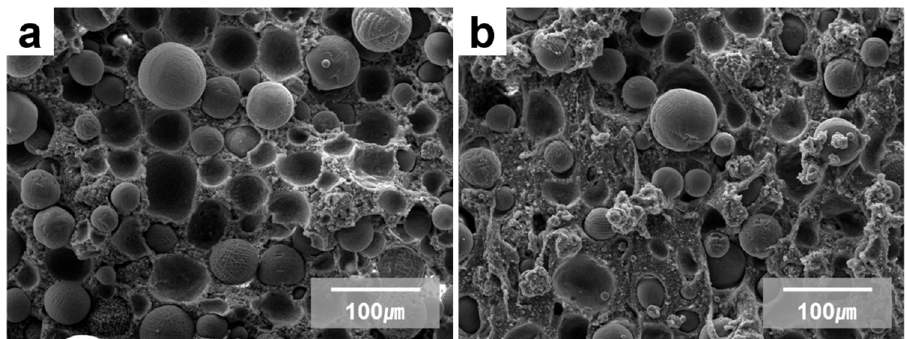
Figure 5. Cross-sectional SEM image of thermal pads using aluminum oxide and zinc oxide powder of ( a ) type B-ZnO 10 and ( b ) type E-ZnO 10.